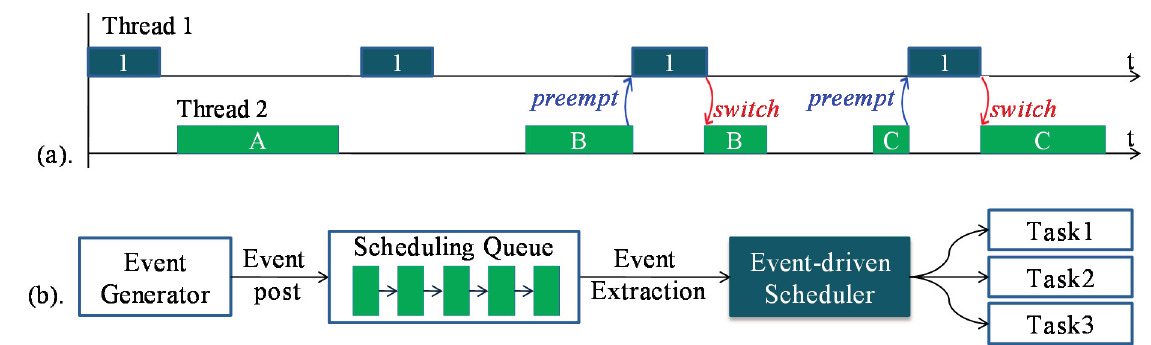
Figure 1. ( a ) Multithreaded scheduling system. Threads can preempt each other, thus